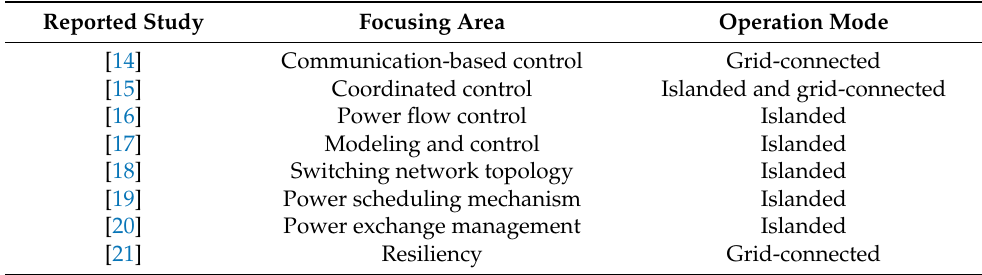
Table 1. Comparison of the reported studies on DC MG